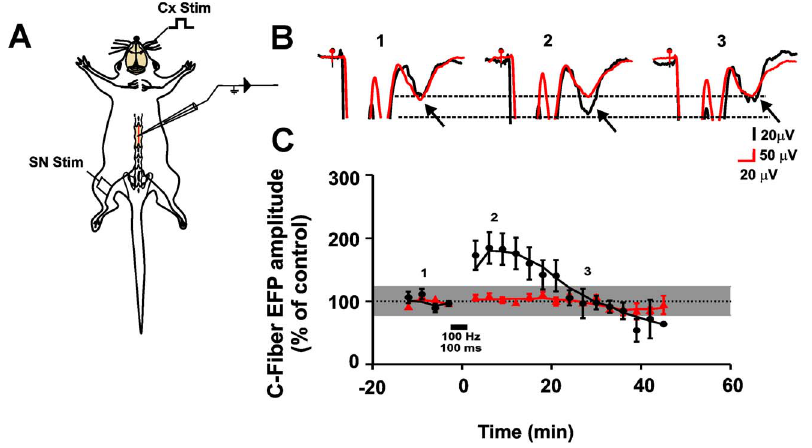
Figure 2. Effect of sensorimotor cortex stimulation on PTP of C–fiber EFPs. A, Schematic diagram of the experimental arrangement. B, averaged (n=16) electrophysiological recordings obtained before (1), after 10 min (2), and after 20 min (3) of high-frequency stimulation of the SN in control conditions (black) and when the SN high-frequency stimulation was applied in parallel with high-frequency stimulation of the contralateral sensorimotor cortex (red). C , PTP temporal course of C–fiber EFPs after a stimulation train of 100 ms delivered to the SN alone (black symbols) and when the SN high-frequency stimulation was applied in parallel with high-frequency stimulation to the contralateral sensorimotor cortex (red symbols). The symbols outside the gray band are statistically different from the basal responses (Friedman test, p , 0.05).